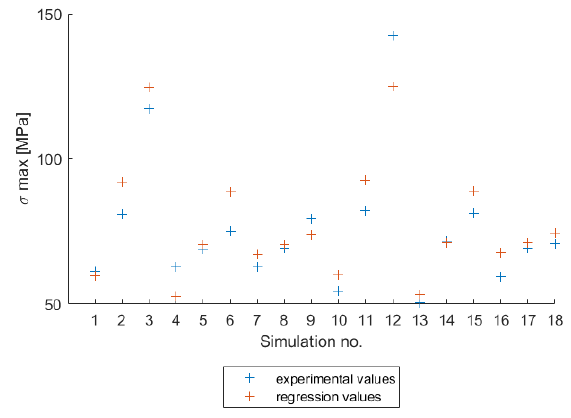
Figure 19. σ max Comparison experimental values and regression values